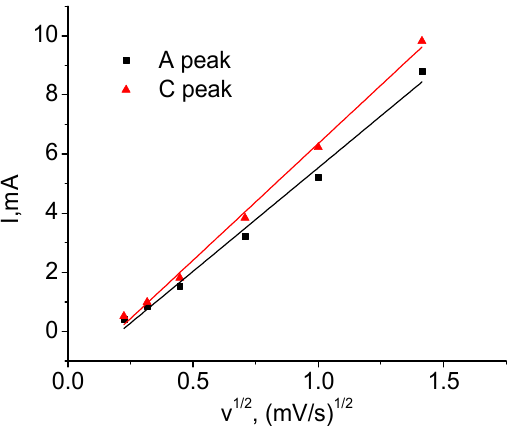
Figure 8. Height of the cathode and anode peaks as a function of voltage sweep speed (T1).